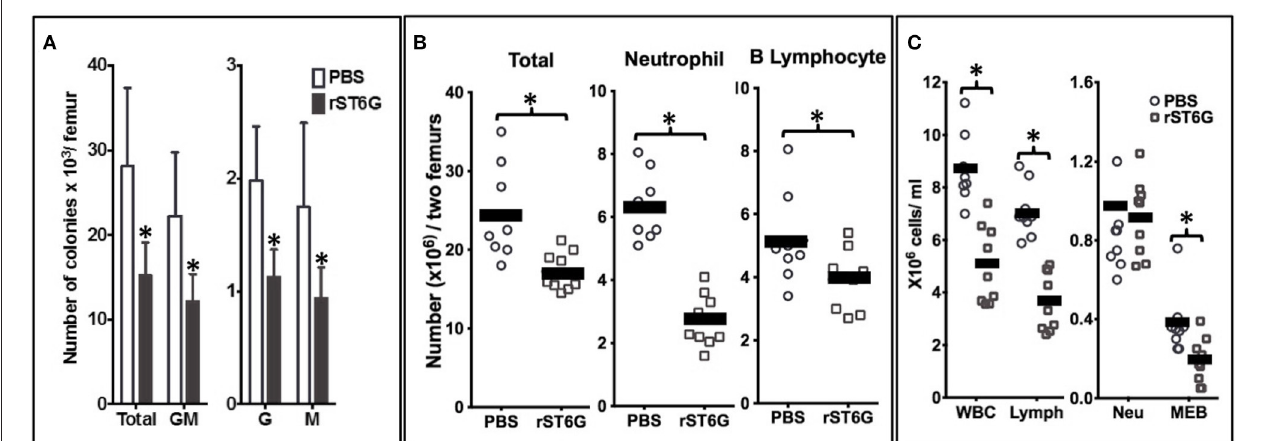
FIGURE 3 | Intravenous rST6G infusion depresses myelopoiesis and alters inflammatory cell availability . WT mice receiving either a single 300 µ g bolus of recombinant ST6Gal-1 (rST6G) or saline (PBS) were sacrificed 7h later. Bone marrow cells from hind limbs and peripheral blood were isolated and analyzed as follows. (A) presents marrow progenitor clonogenic activity for granulocyte/monocyte (GM), granulocyte (G), or monocyte (M) progenitor colonies. The combined total colony formed is also shown (Total). Saline- (open bars) and rST6G-treated mice ( n = 9 each group) were used with 4 × 10 4 marrow cells were plated in Methocult M3534 to promote growth of myeloid progenitors for 10 days. * p < 0.0 1 rST6G compared to PBS. (B) summarizes the overall bone marrow cellularity of PBS (round symbols) and rST6G-treated (square symbols) animals, where each symbol denotes one animal. Total bone marrow cellularity (Total), and neutrophil and B cell